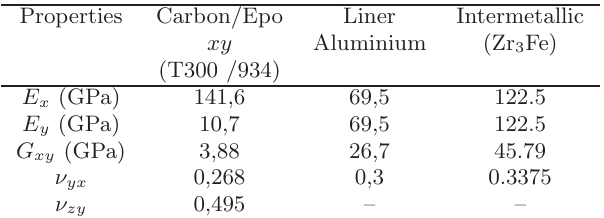
Table 1. Elastic parameters. Table 2. Different stacking sequences of the composite